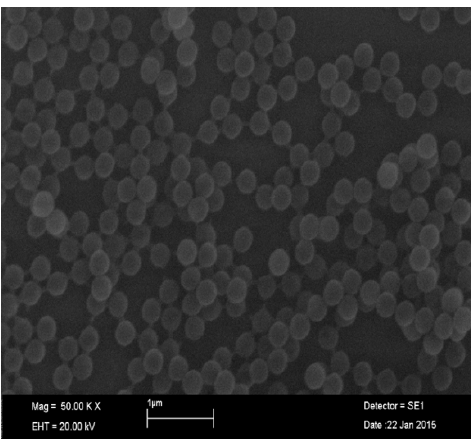
Fig.4: SEM image for floating deposition technique.